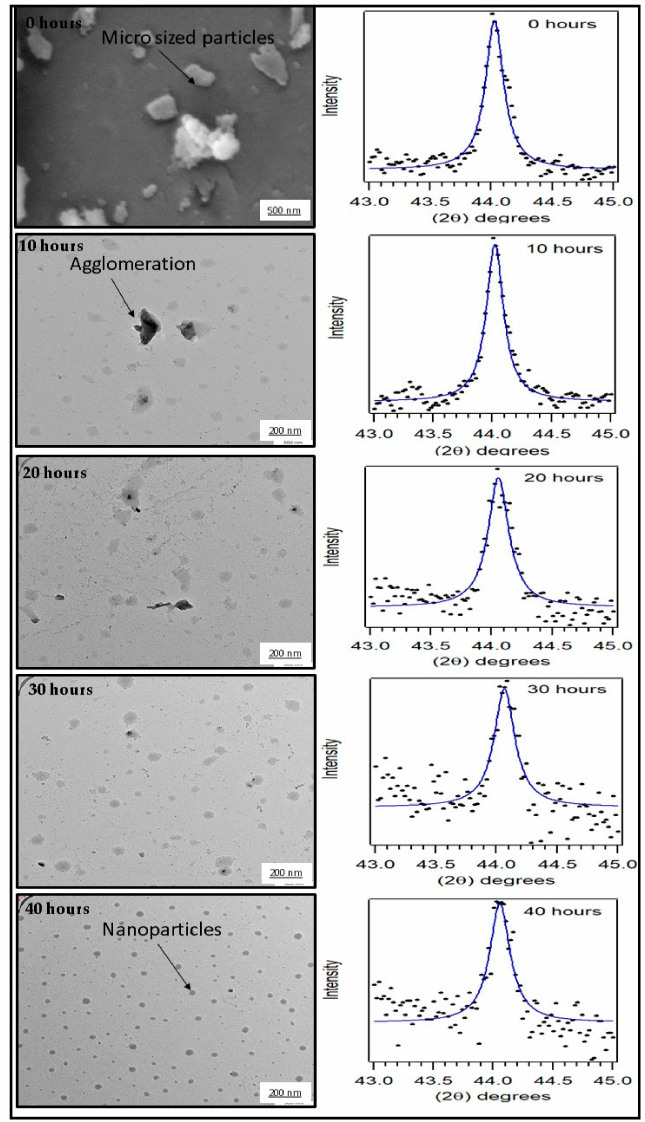
Figure 1. TEM and XRD data (Fe 2 O 3 peak) of coconut shell particle (dots) at 0, 10, 20, 30, and 40